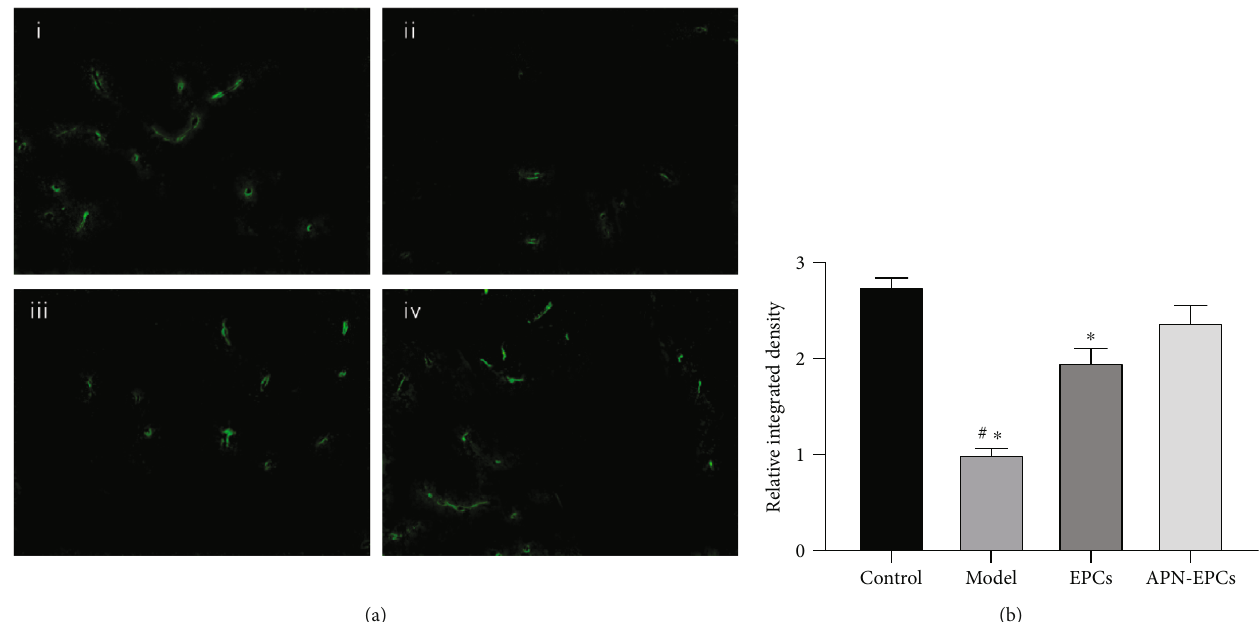
Figure 7: In fl uence of APN-EPC treatment on microvessel density. (a). CD31 immuno fl uorescence staining in the hippocampus (x400); (i) control group, (ii) model group, (iii) EPC group, and (iv) APN-EPC group. (b). Quantitative result of microvessel density. ∗ p < 0 : 05 the model group or the EPC group compared with the APN-EPC group, # p < 0 : 05 the model group compare with the control